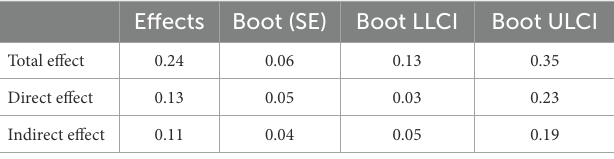
TABLE 3 Total effect, direct effect, and indirect effect.